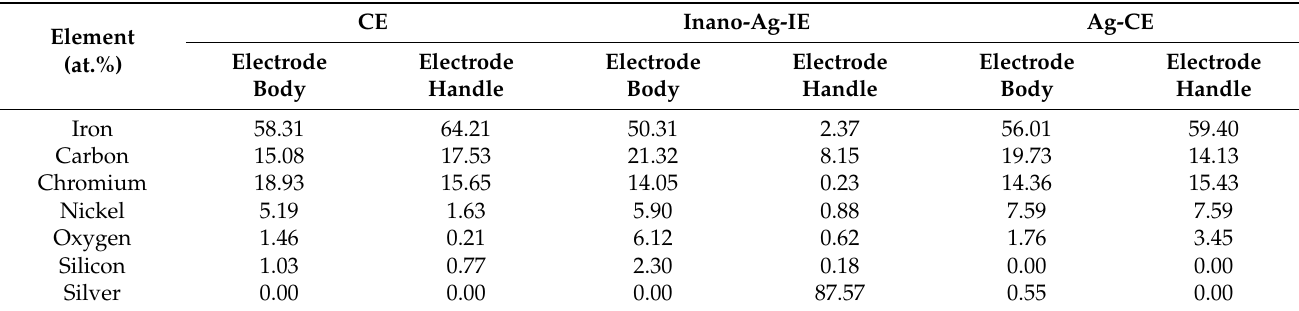
Table 1. List of elements detected by EDS from the CE, Inano-Ag-IE, and Ag-CE samples, and their atomic weight percentage (at.%) per.